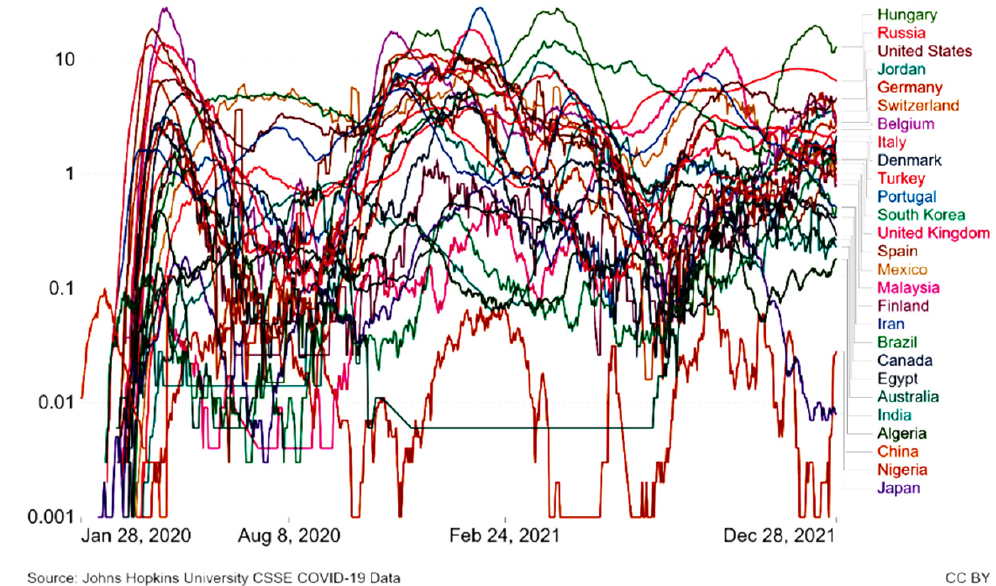
Figure 2. The daily confirmed COVID-19 deaths per million people in the studied countries in logarithmic form.